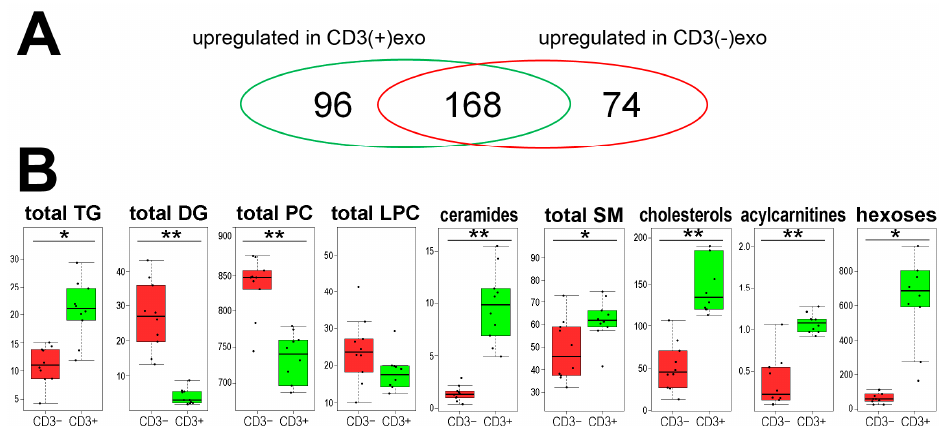
Figure 3. The metabolites that were identified in the CD3(+) and CD3( − ) fractions of the sEVs from human plasma: ( A ) a Venn diagram showing the numbers of metabolites that were significantly upregulated in either fraction (FDR < 5%); ( B ) the abundance of the major classes of metabolites that were detected in the CD3(+) and CD3( − ) fractions of the sEVs. The aggregated amounts of the major classes of lipids are also shown (TG, triglycerides; DG, diglycerides; PC, phosphatidylcholines; LPC, lysophosphatidylcholines; SM, sphingomyelins). The box plots represent the minimum, lower quartile, median, upper quartile and maximum. The dots represent the individual samples. The significance of difference between both fractions of sEVs is marked with asterisks (* FDR < 0.05; ** FDR <